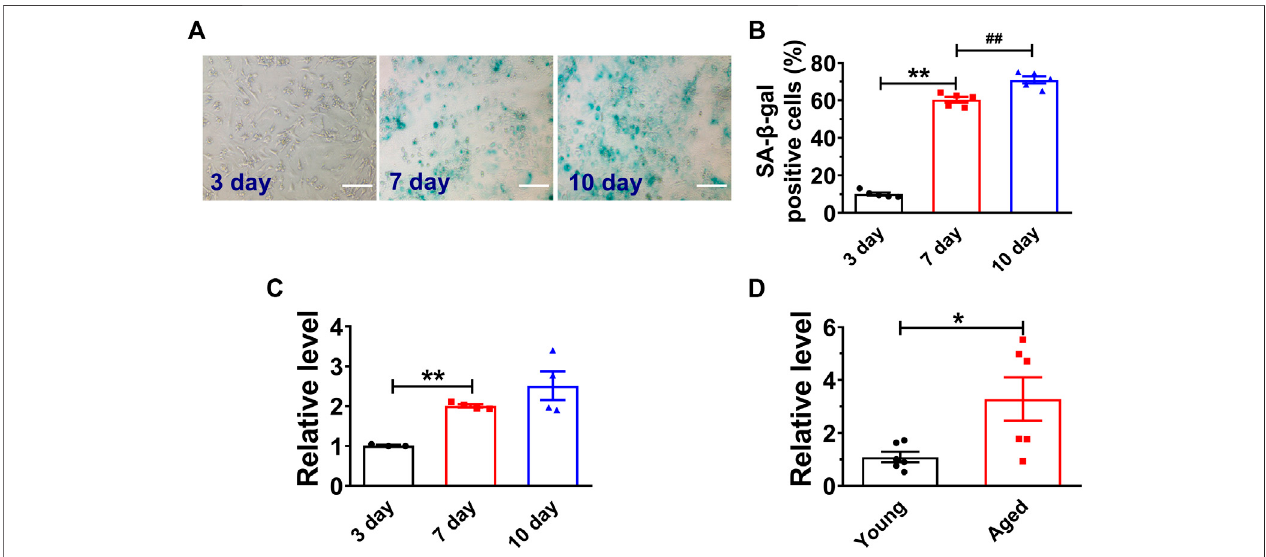
FIGURE 1 | H19 is upregulated in senescent cardiomyocytes and aged mice heart. (A,B) Representative images of SA- β -gal staining and the averaged results showing the time-dependent increases in the percentage of SA- β -gal positive cells in NMVCs under high glucose conditions. Scale bars (cid:2) 50 μ m. (C) Time-dependent increases in the expression level of H19 in cardiomyocytes with varying exposure durations to high glucose. (D) Increased expression of H19 in aged mice hearts. Data are expressed as mean ± SEM, * p < 0.05 vs. Young, ** p < 0.01 vs. 3 days, ## p < 0.01 vs. 7 days, n (cid:2) 5 or 6.